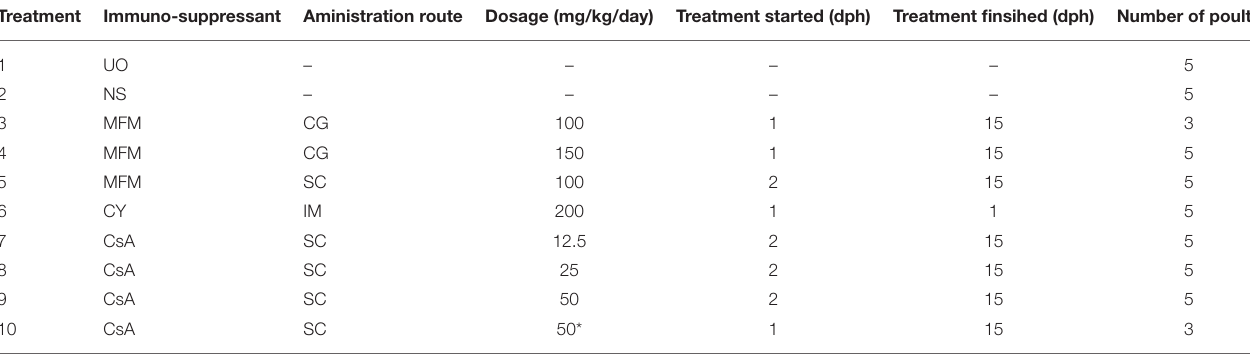
TABLE 2 | Study 2 treatment